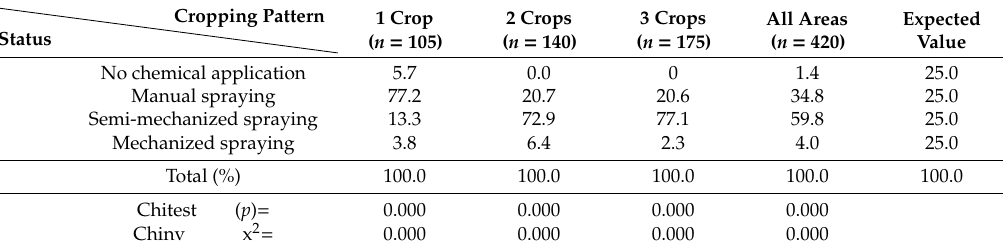
Table 13. Current status of chemical spraying method (%).